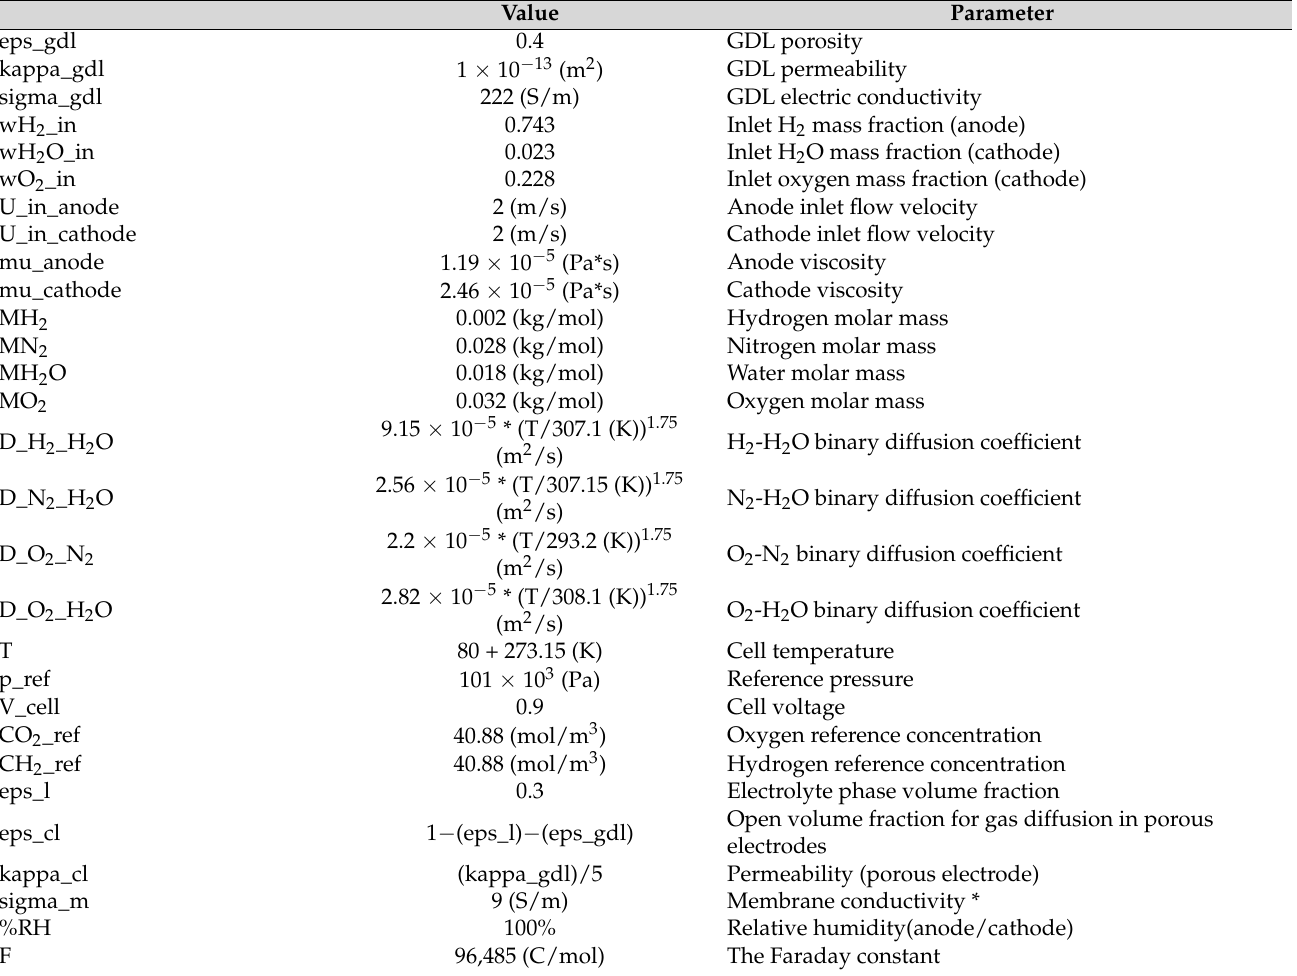
Table 3. Main parameters of membrane, GDL, CL and reaction